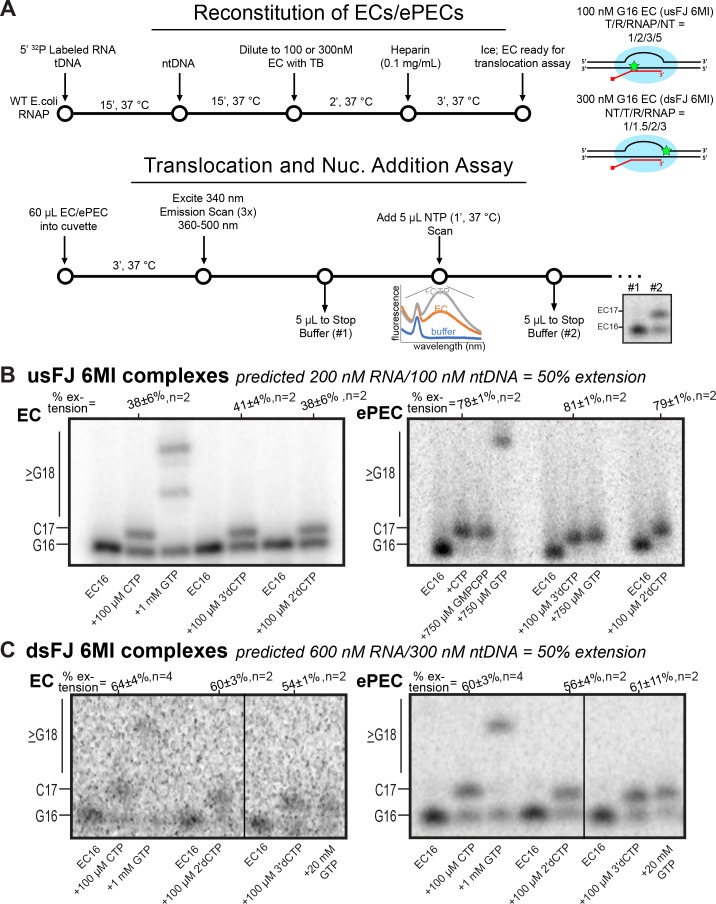
Reconstitution of ECs and PECs for 6-MI translocation assays.(A) Experimental schematic for the assay of translocation and nucleotide addition. (B) Nucleotide addition for samples used in translocation assays of usFJ 6MI complexes (EC, left; ePEC, right). Percentages above extension lanes indicate the fraction of RNA extended (vs. the prediction of 50% based on reconstitution ratios). Error is range for n = 2 or SD for n ≥ 3. (C) Nucleotide addition for samples used in translocation assays of dsFJ 6MI complexes (EC, left; ePEC, right). Percentages above extension lanes indicate the fraction of RNA extended (vs. the prediction of 50% based on reconstitution ratios). Error is range for n = 2 or SD for n ≥ 3.